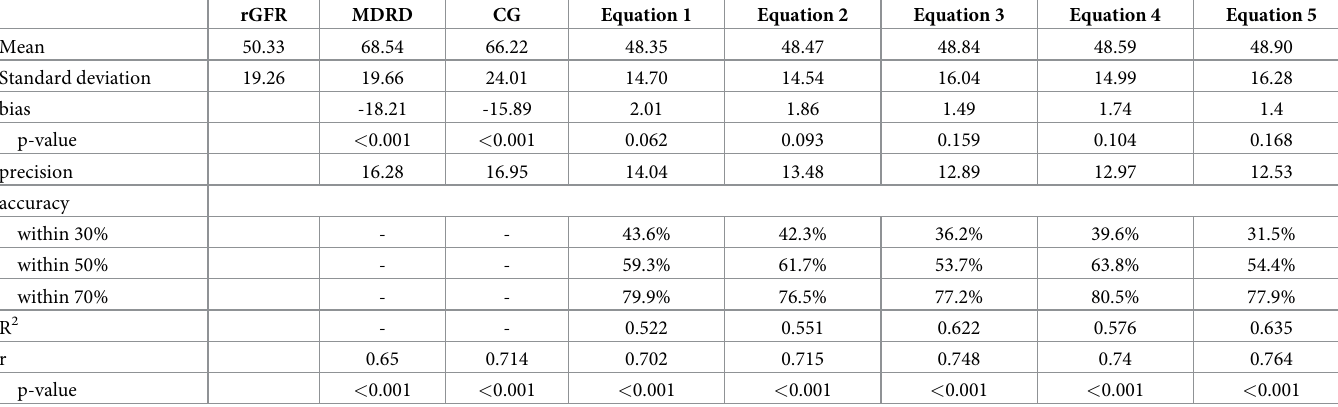
Table 2. Comparison of the error values, precision and relevance of each GFR